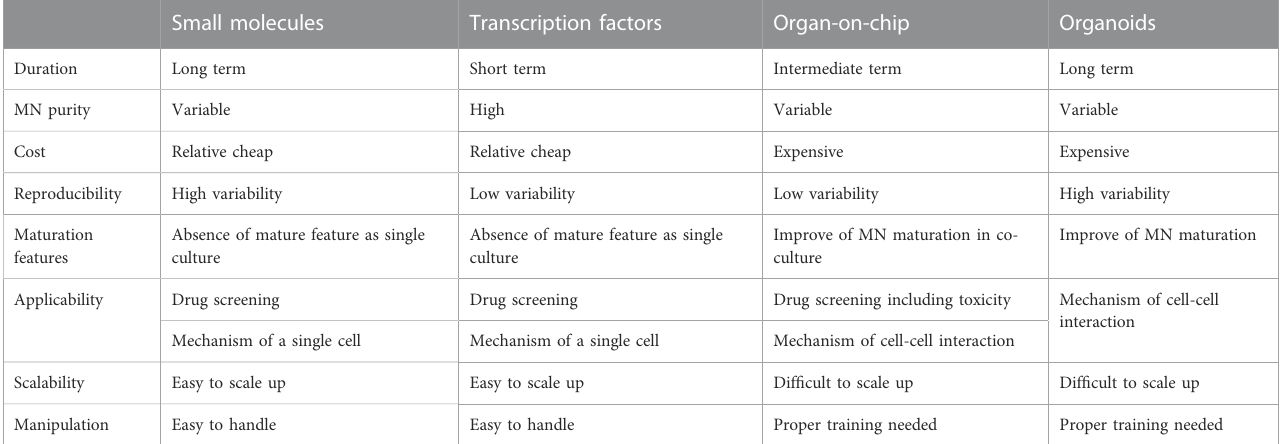
TABLE 3 Advantages and disadvantages of different approaches to obtain MNs in